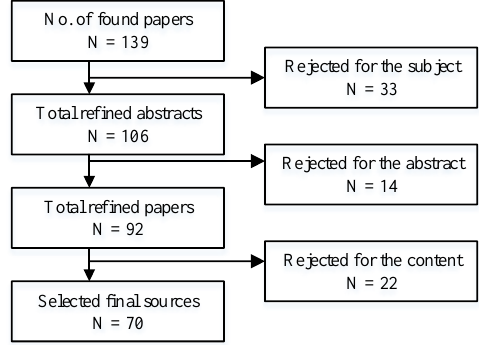
Figure 1. Refinement procedure for paper